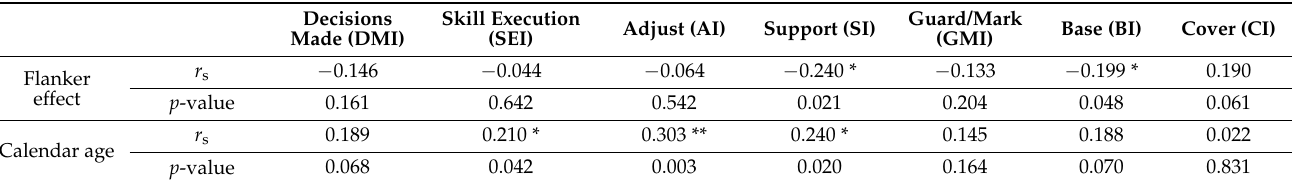
Table A3. Spearman-rho partial correlations between flanker effect, calendar age, and the subscores of coach rated game performance